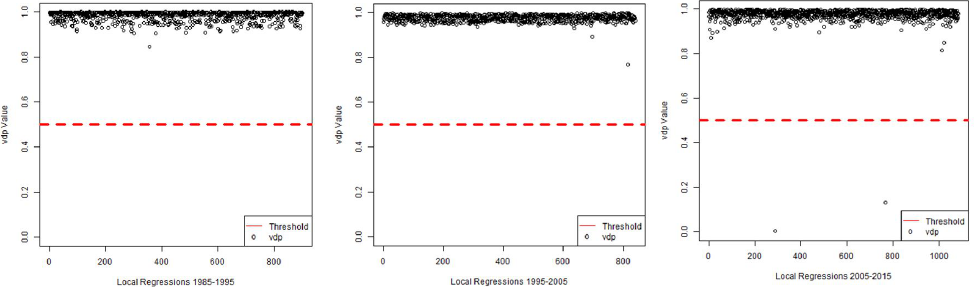
Figure 7. Multicolleanirity diagnostics analysis of the variables in GWR